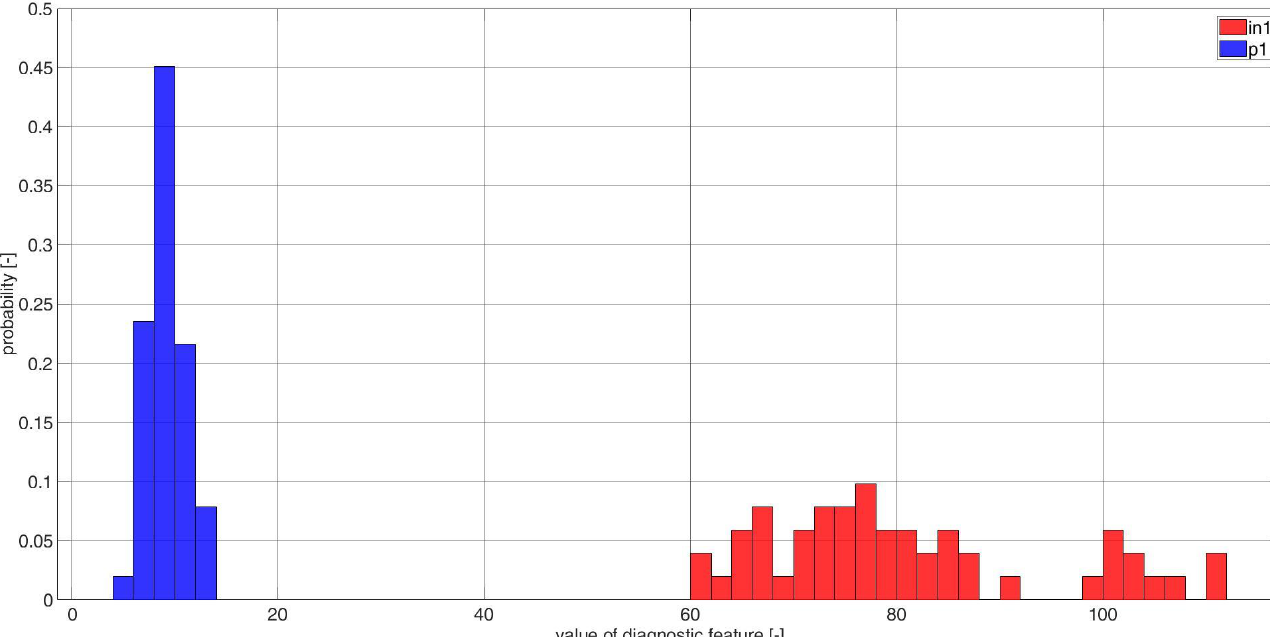
Figure A6. Histogram of diagnostic features based on the CCSM3 (correlation number is 6 — Table A1) bearings in2 and p2.